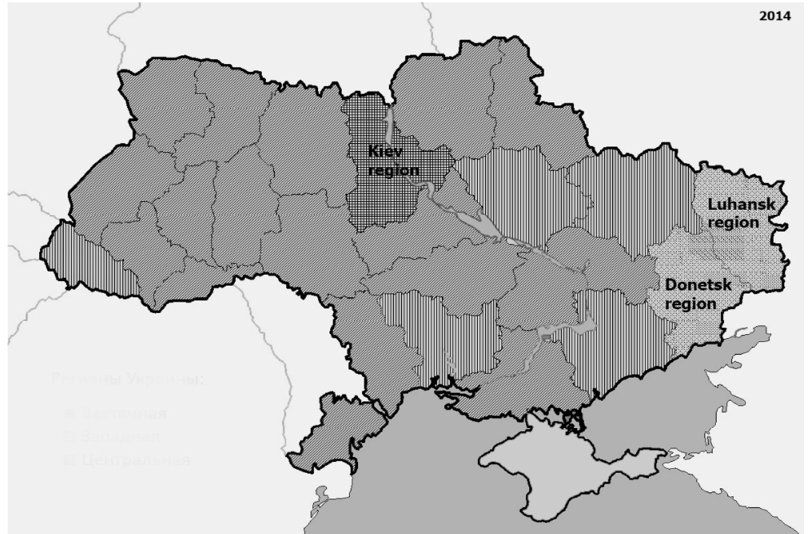
Figure 8. Mapping sustainable development of regions in Ukraine according to their affiliation to the attributive groups in